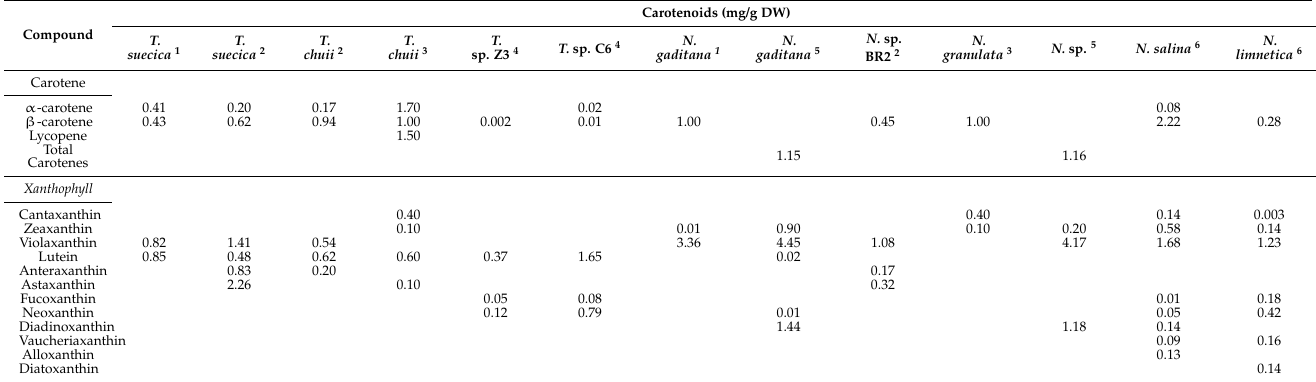
Table 5. Carotenoids composition (expressed as mg/g of dry weight, DW) of Nannochloropsis sp. and Tetraselmis sp.